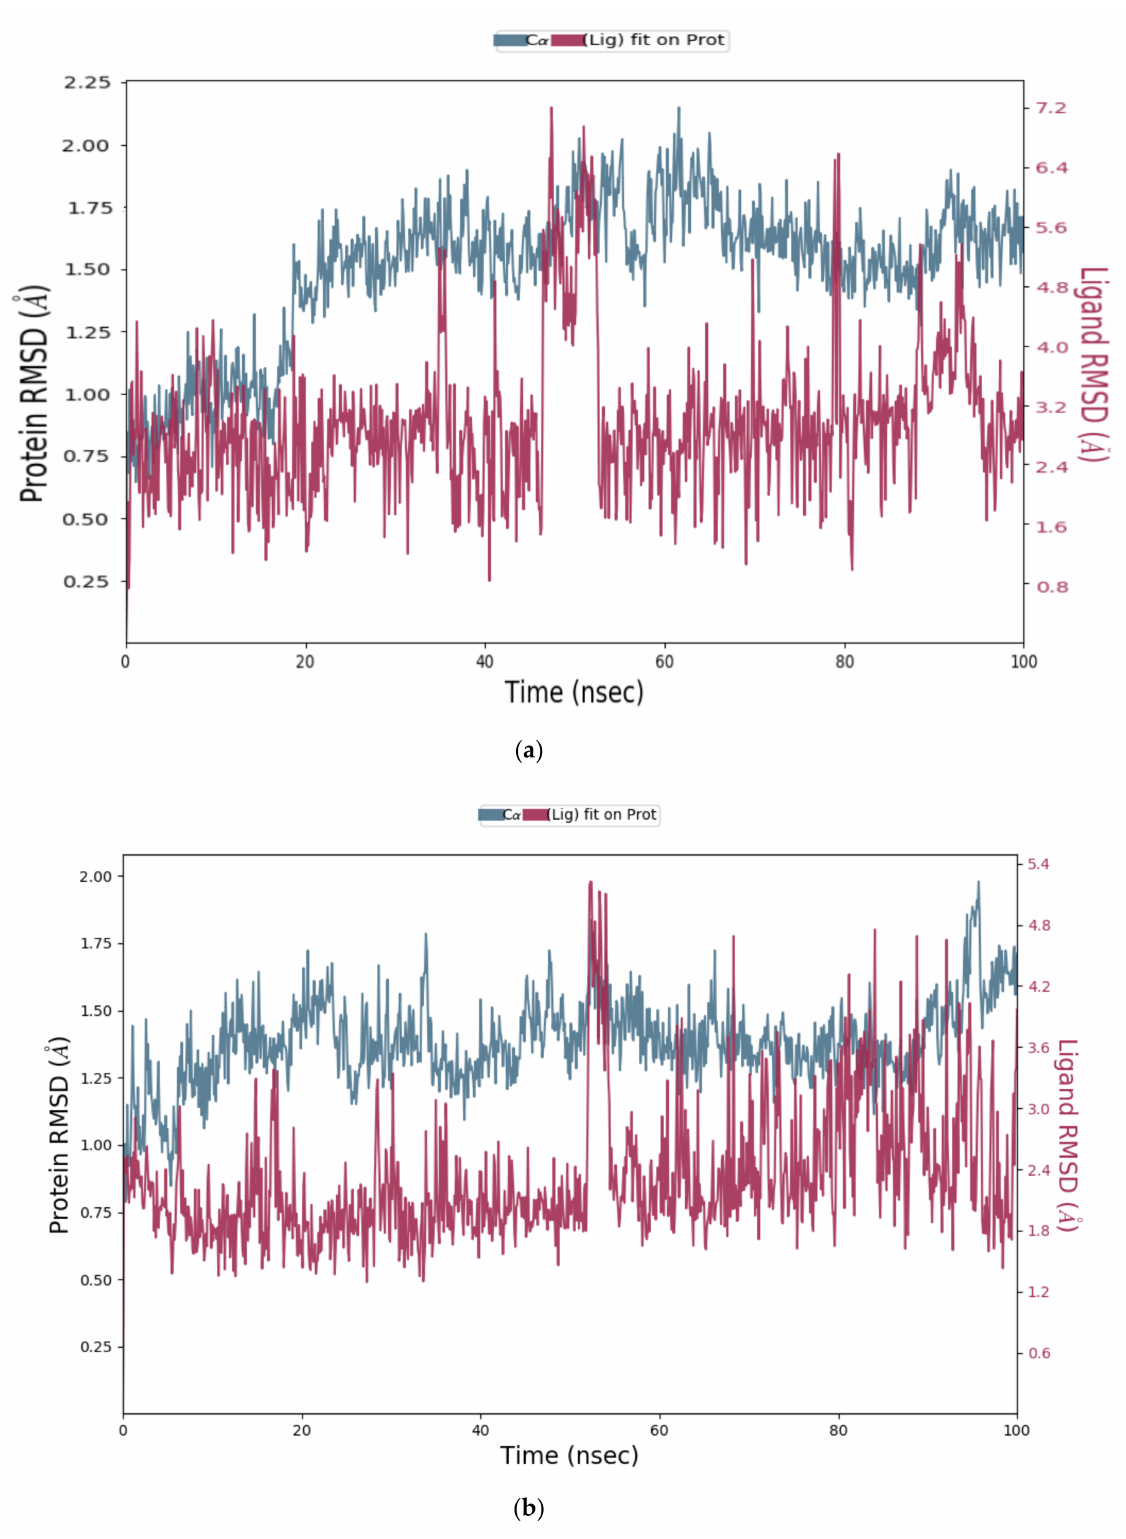
Figure 12. RMSD graph of ( a ) Cathepsin L-DTBN; ( b ) Cathepsin L-iDTBN covalent